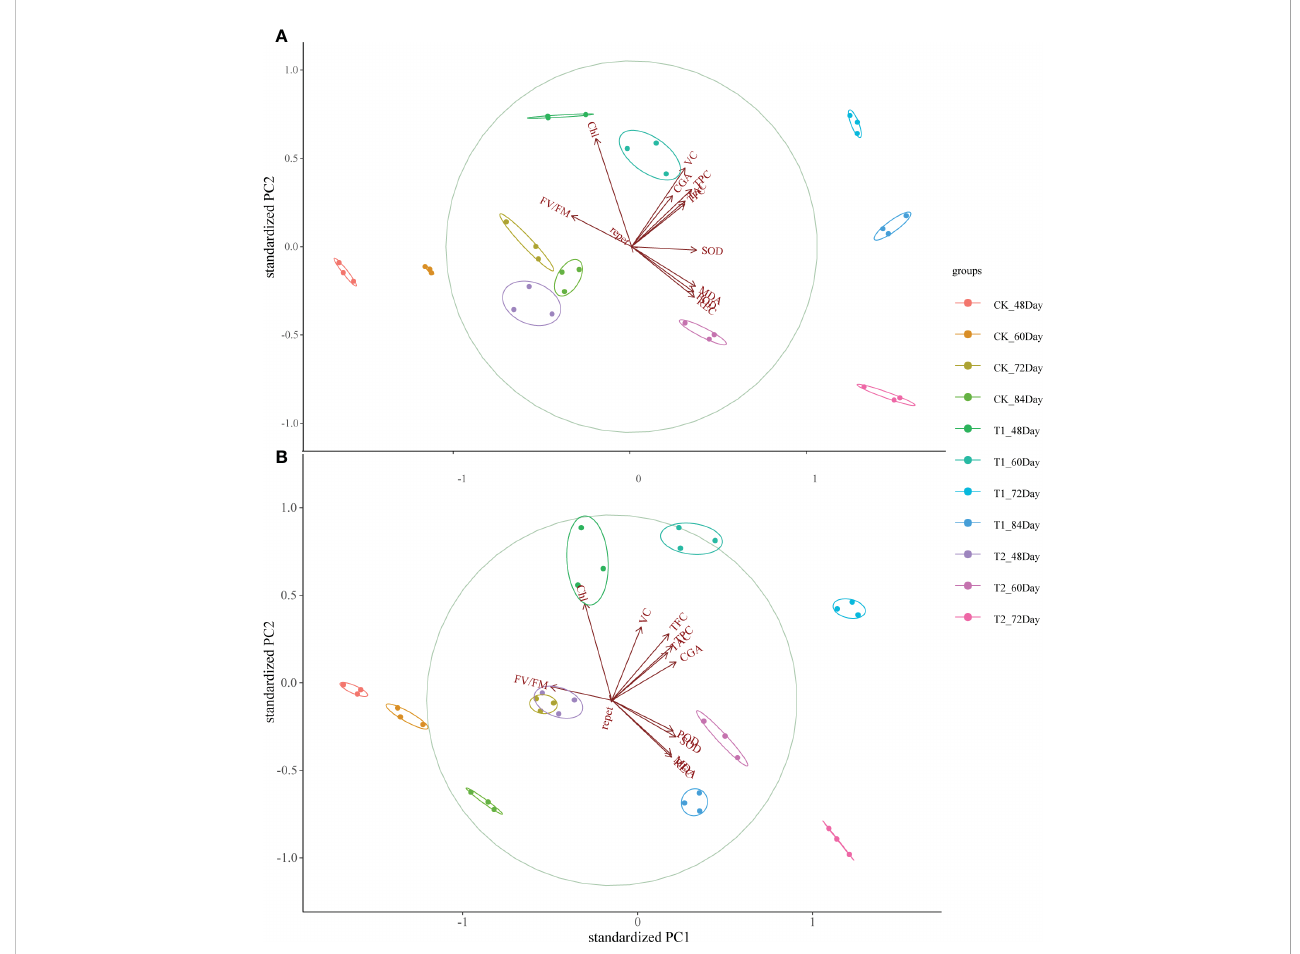
FIGURE 5 Principal component analysis (PCA) between leaf stress physiological indexes and tuber nutrient components of the whole growth period of “ Huaxinyangyu ” and “ Jianchuanhong ” plants under different UV-B treatments. (A) ” Huaxinyangyu ” PCA, (B) ” Jianchuanhong ” PCA. TPC, total phenol; CGA, chlorogenic acids; TFC, total fl avonoid; TAC, total anthocyanin content; V C , vitamin C; REC, relative permeability; Chl, chlorophyll; MDA, malondialdehyde content; SOD, superoxide dismutase; POD, peroxidase; FV/FM, Chlorophyll fl uorescence parameter. (According to the Duncan test, different letters indicate a signi fi cant difference (p< 0.05) among the treatments. The error bars represent the mean ±